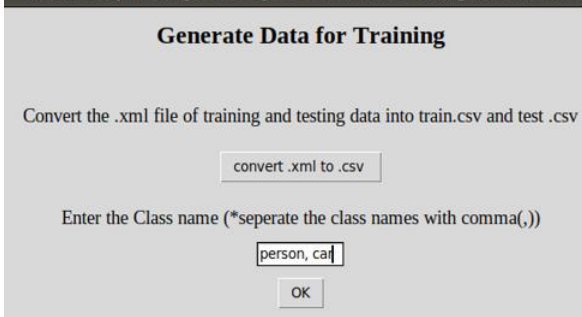
Figure 11. Generate data for Faster R-CNN